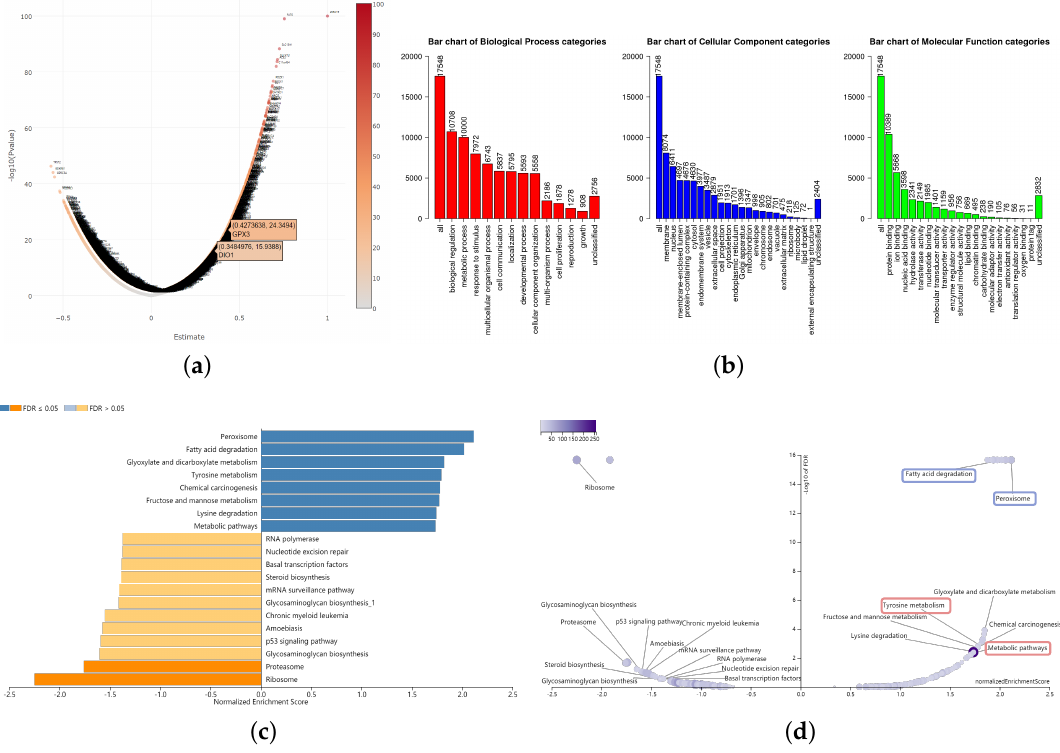
Figure 6. Significant enrichment plots of LRRC19, using gene set enrichment analysis (GSEA). ( a ) Genes differentially expressed in correlation with LRRC19 in KIRCs. The positions of the dots representing GPX3 and DIO1 are marked. ( b ) Gene Ontology (GO) Slim summary for the LRRC19 association results. Each biological process (BP), cellular component (CC), and molecular function (MF) category is represented by a red, blue, and green bar, respectively. The height of the bar represents the number of IDs in the user list as well as in the category. The significantly enriched Kyoto Encyclopedia of Genes and Genomes (KEGG) pathways of LRRC19 co-expression genes in KIRC were analyzed by GSEA. The enriched KEGG pathway result was clustered with affinity propagation for redundancy reduction, and clustered pathways are shown. ( c ) In the bar plots, the color scale represents the FDR value, and the length of the bar represents the normalized enrichment score (NES) value (positive correlated, blue > 0; and negative correlated, orange < 0). ( d ) In the volcano plots, the intensity of color and jitter size indicates the number of the elements in each pathway. The four pathways of interest are framed; purple indicates GPX3 correlation and pink indicates DIO1